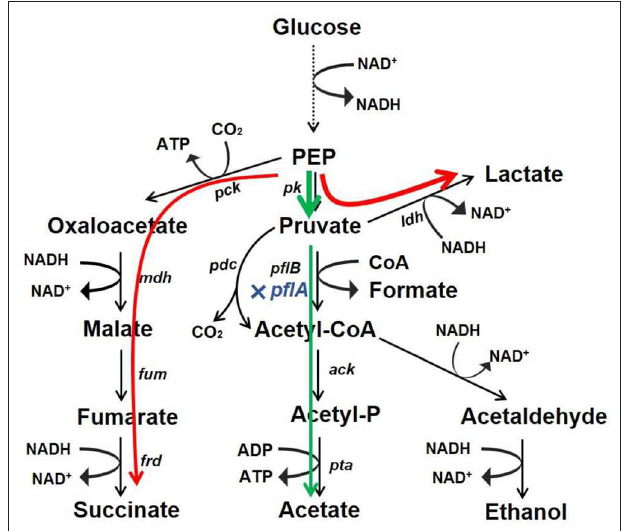
FIGURE 6 | Expression levels of genes related to organic acid biosynthesis pathway in the 130Z strain (A) and 1 pflA strain (B) under different cultivation modes.